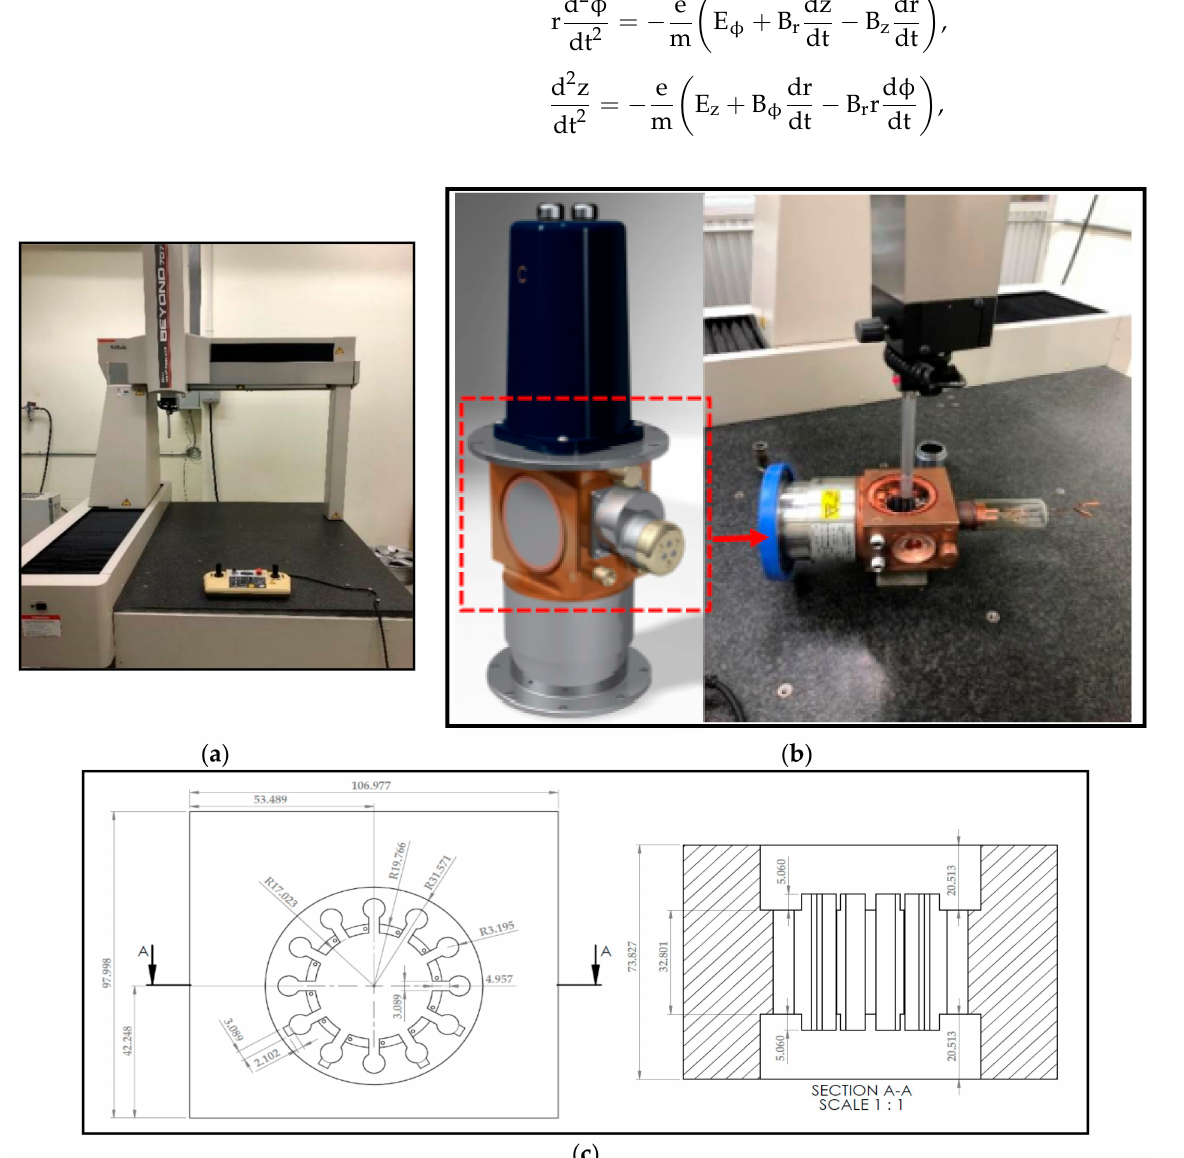
Figure 2. Structural dimensions measured by using coordinate measuring machine. ( a ) CMM Mitutoyo Beyond 707; ( b ) Internal structure measurement; ( c ) 3D